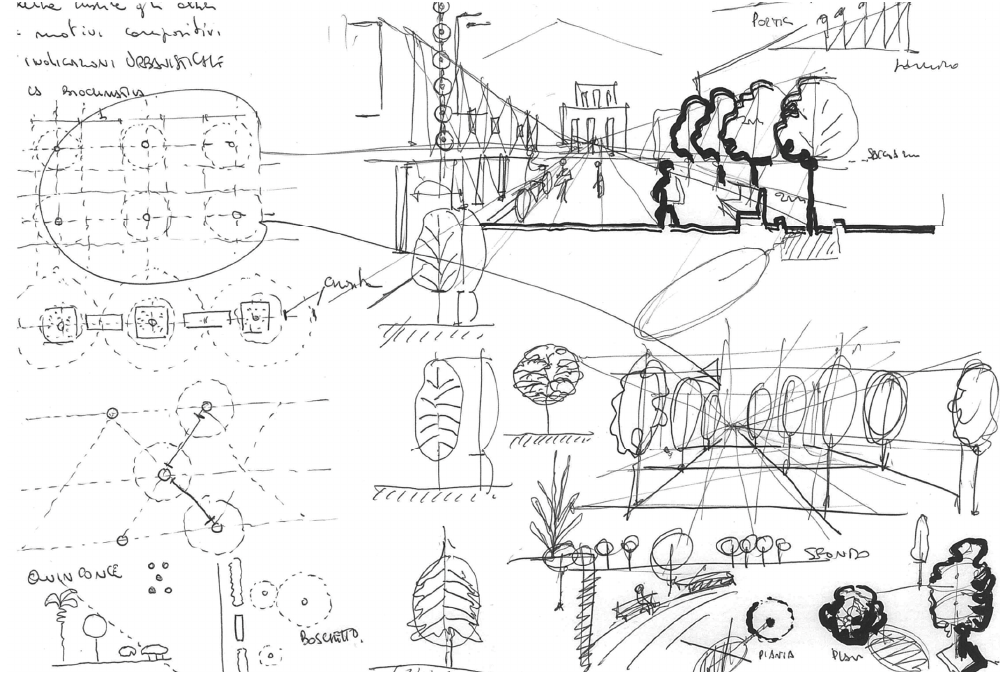
Figure 1. Architectural studies and sketches (by tutor Giuseppe Maria